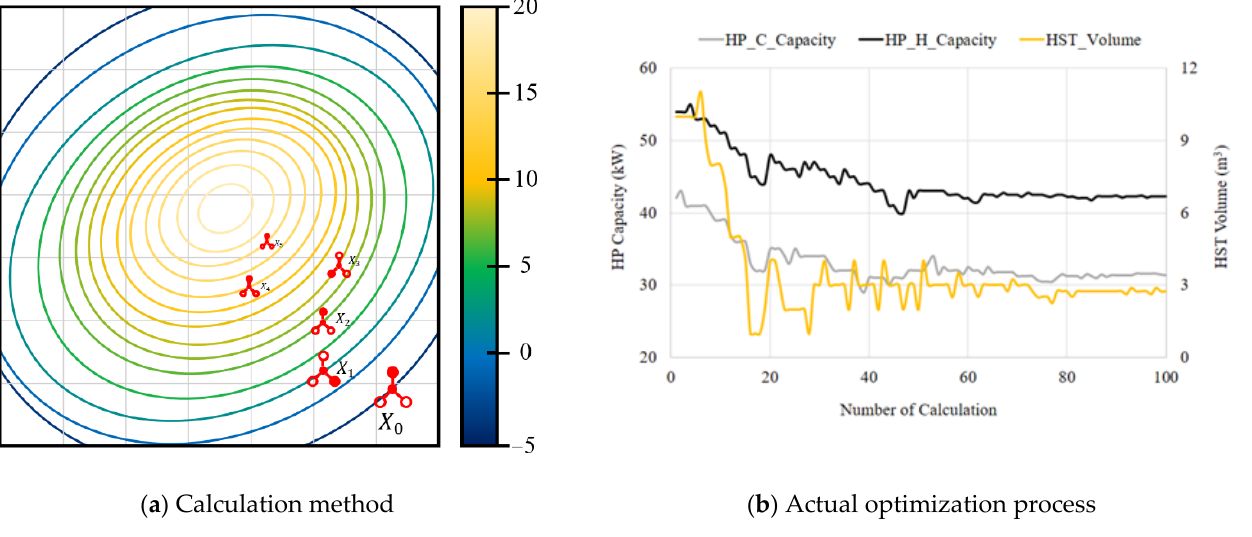
Table 5. Specifications of economic analysis.